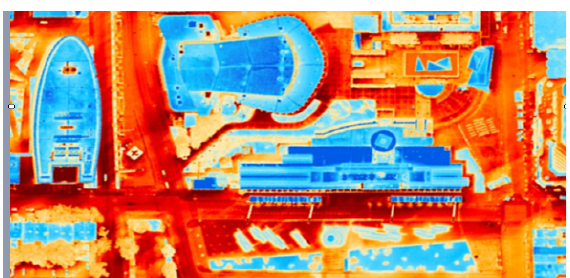
Figure 1. At the first phase of this project in 2012, nocturnal temperature measurement at 80 cm resolution demonstrated the thermal behaviour of various surface cover materials, Place des festivals